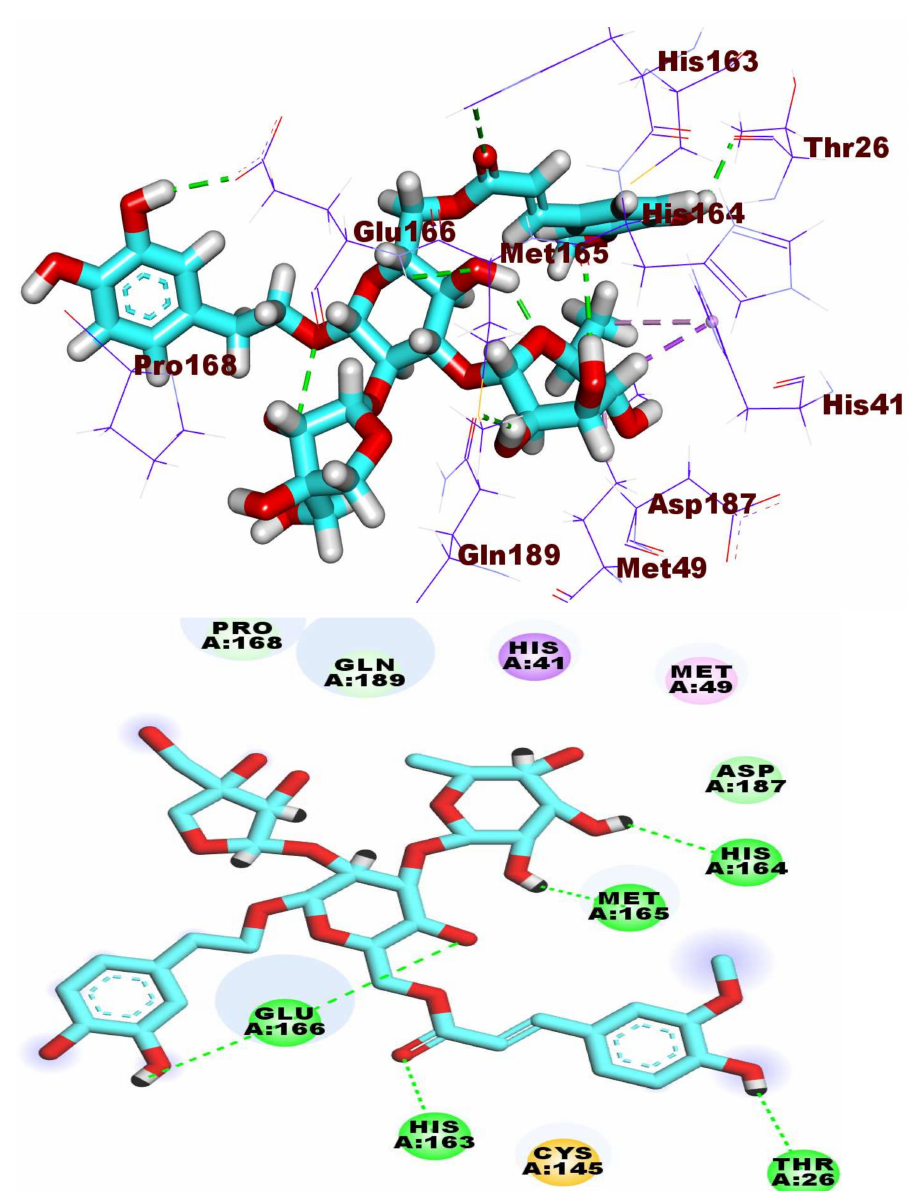
Figure 6. The binding pattern of compound 130 inside the M pro PDB ID: 6LU7 active site. The antiviral compound 184 (affinity value of − 30.15 kcal/mol) revealed the engage- ment in many H-bonding as well as hydrophobic interactions in the different pockets of the main protease active pocket. At first, the 2-acetamido- N -((1-(isopentylamino)-1- oxopropan-2-yl)propanamide moiety was involved in four hydrogen bonds with Glu166, Asn142, and His 163 in the first pocket. Likely, the 2-formamido- N ,4-dimethyl pentanamide moiety made two hydrogen bonds with Gln189 in the second pocket. Moreover, compound 184 was buried in the second pocket through the formation of one hydrogen bond with the amino acid Met165 and two hydrophobic interactions with the amino acid Met49 using its 1 H -indole moiety (Figure